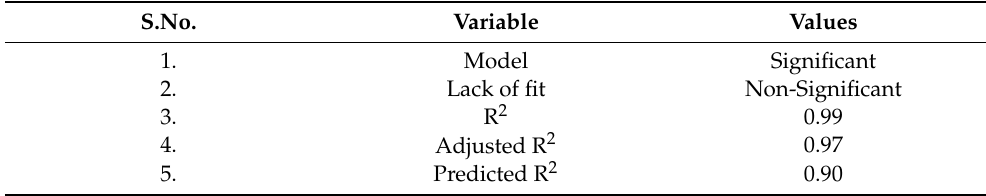
Table 6. Assessment of the RSM model.